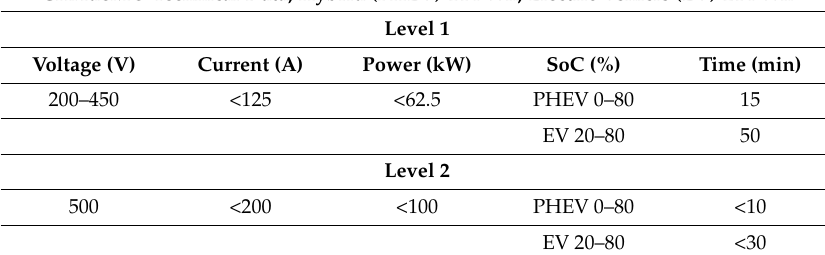
Table 2. CHAdeMO (CHArge de Move) technical